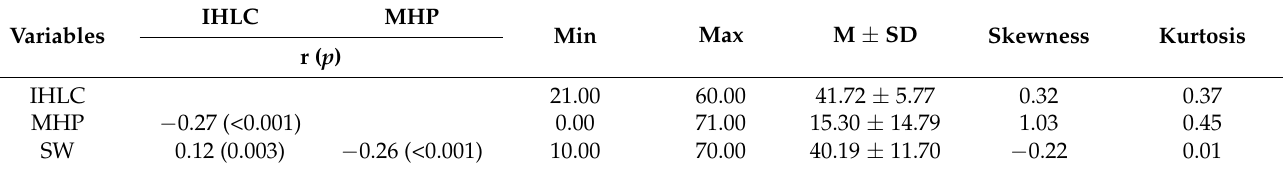
Table 2. Descriptive Statistics and Correlations of Measured Variables ( n =